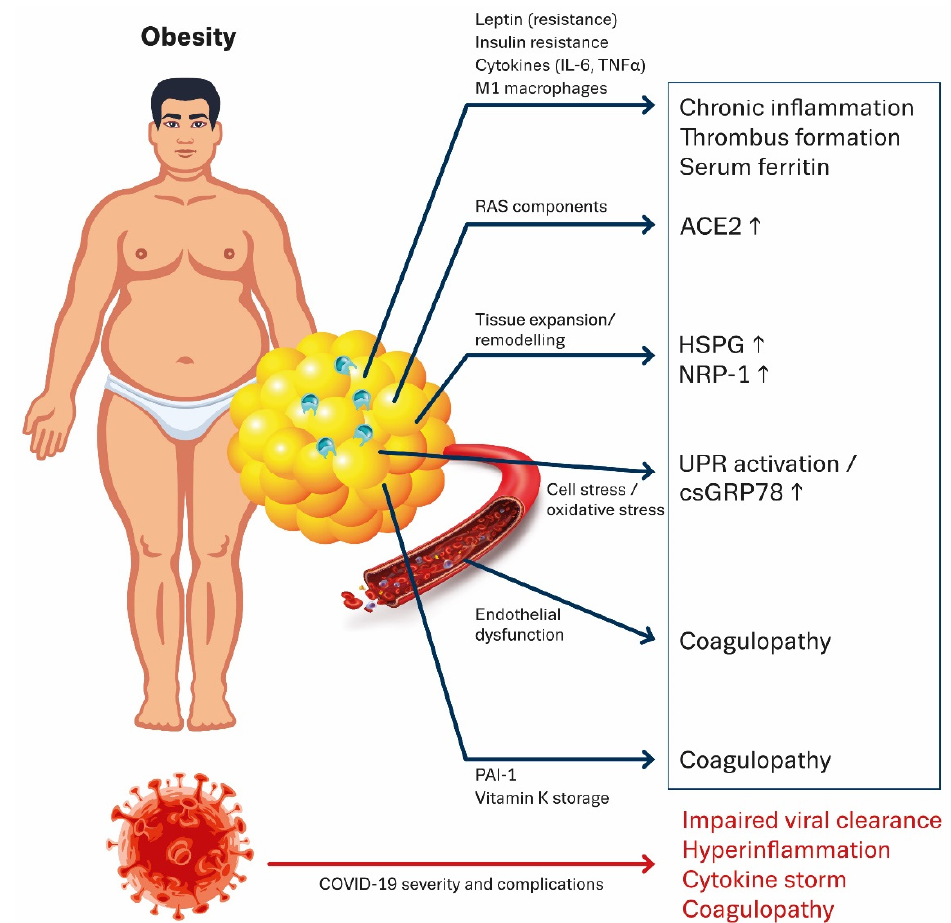
Figure 1. Schematic representation of different mechanisms through which obesity can promote COVID-19 disease severity and risk for complications. Obesity is often accompanied by insulin and leptin resistance which impairs viral clearance. Next, obesity is characterized by large hypoxic adipocytes infiltrated with immune cells and M1 macrophages leading to a chronic inflammatory state, hypercoagulability and hyperferritinemia. ACE2 produced by adipocytes could provide viral entry into the adipose tissue. In this way the adipose tissue could possibly function as a reservoir for the virus. The constant tissue expansion and tissue remodeling accompanying obesity in concert with high cell stress can upregulate the expression of other potential SARS-CoV-2 receptors, such as csGRP78, HSPG and NRP-1 in adipose tissue and other organs. Obesity-associated endothelial dysfunction, enhanced production of PAI-1 and vitamin K deficiency all increase the risk of developing COVID-19 associated coagulopathy. Abbreviations: IL-6 = Interleukin-6; TNF α = Tumor necrosis factor α ; RAS = Renin angiotensin system; ACE = Angiotensin converting enzyme; HSPG = Heparan sulfate proteoglycan; NRP- 1 = Neuropilin-1; UPR = Unfolded protein response; csGRP78 = Cell surface glucose related protein 78; PAI-1 = Plasminogen activator inhibitor 1.